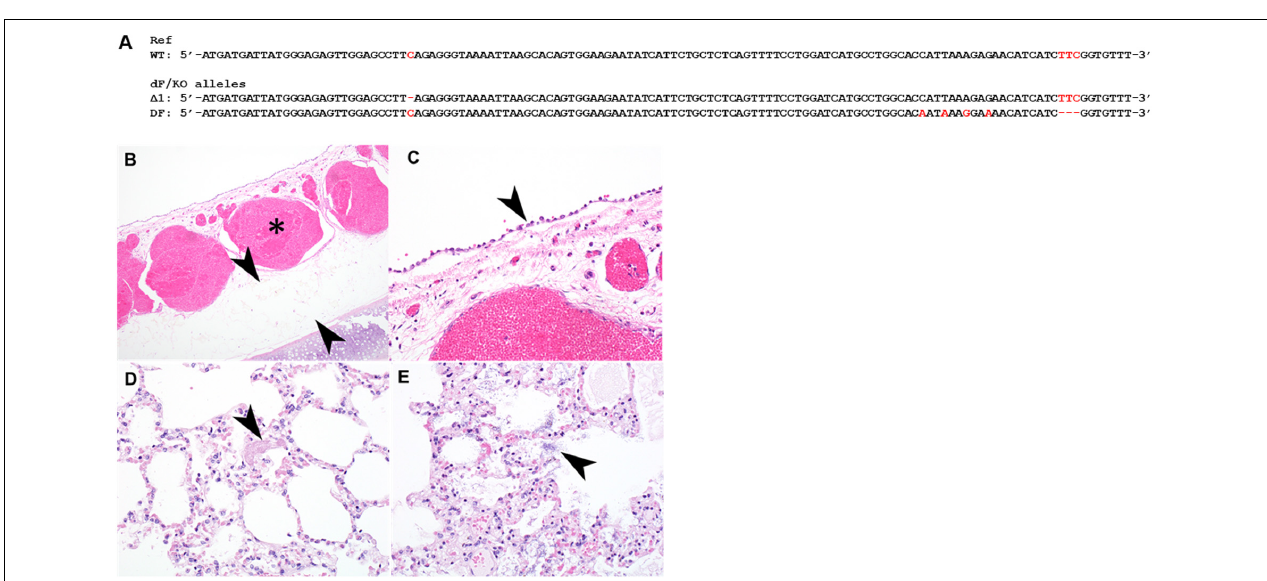
FIGURE 3 | Histopathology of the tracheal and lungs of a heterozygous compound (cid:49) F508/KO rabbit. (A) Illustration of allele sequence of the (cid:49) F508/KO rabbit. Red letters indicate positions of mutations. (B) The submucosa of the trachea was thickened with moderate to marked amounts of edema (arrowheads) and submucosal blood vessels were markedly congested (asterisk). (C) tracheal epithelium was markedly flattened and attenuated (arrowhead). (D) Lung contained variable amounts of fibrin within alveoli (arrowhead), variable amounts of edema, and multifocal rod-shaped bacterial colonies [ (E) ,